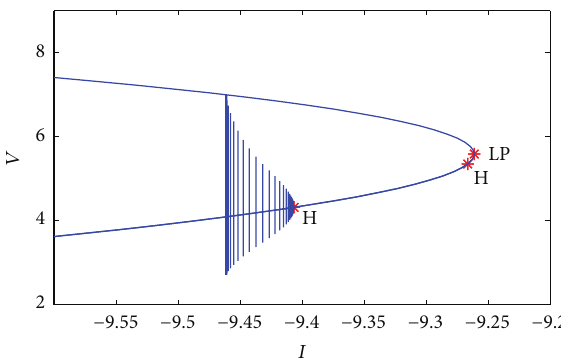
Figure 10: The limit cycle emerging from uH at 𝐼 = −9.406580 .